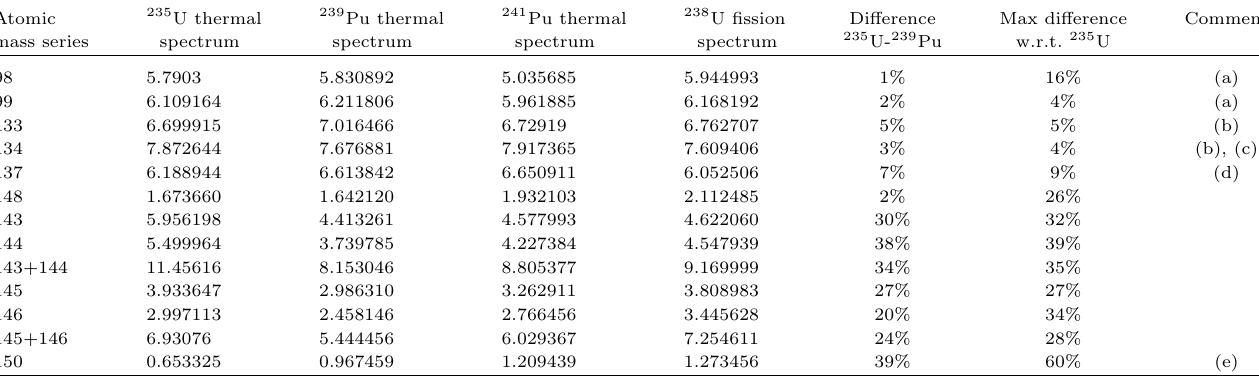
Table 1. Top part: chain fission yield (per 100 fissions) for mass series that show less than 7.5% difference between 235 U and 239 Pu (thermal spectrum fissions), and less than 30% when including 241 Pu (thermal spectrum fissions) and 238 U (fast spectrum fissions). Bottom part: same values for the other Nd isotopes used as burnup indicators at SCK CEN. Source of numerical data: